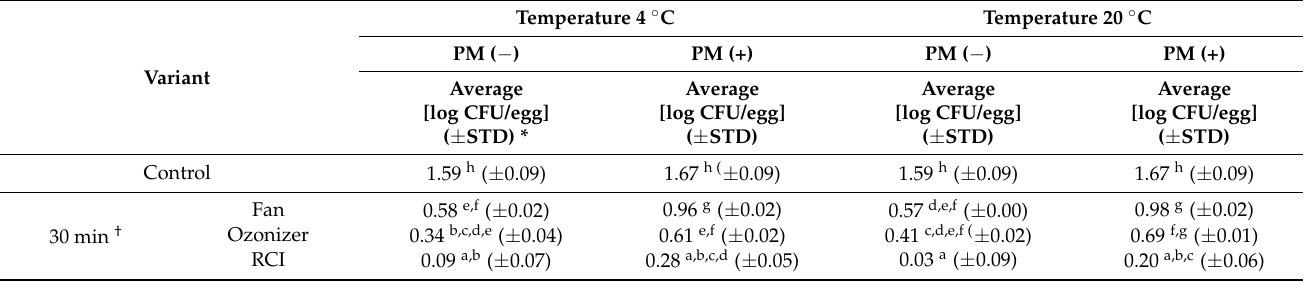
Table 1. The final number of Salmonella spp. on eggshells contaminated with bacterial suspension of 10 3 CFU/mL with or without the addition of poultry manure.